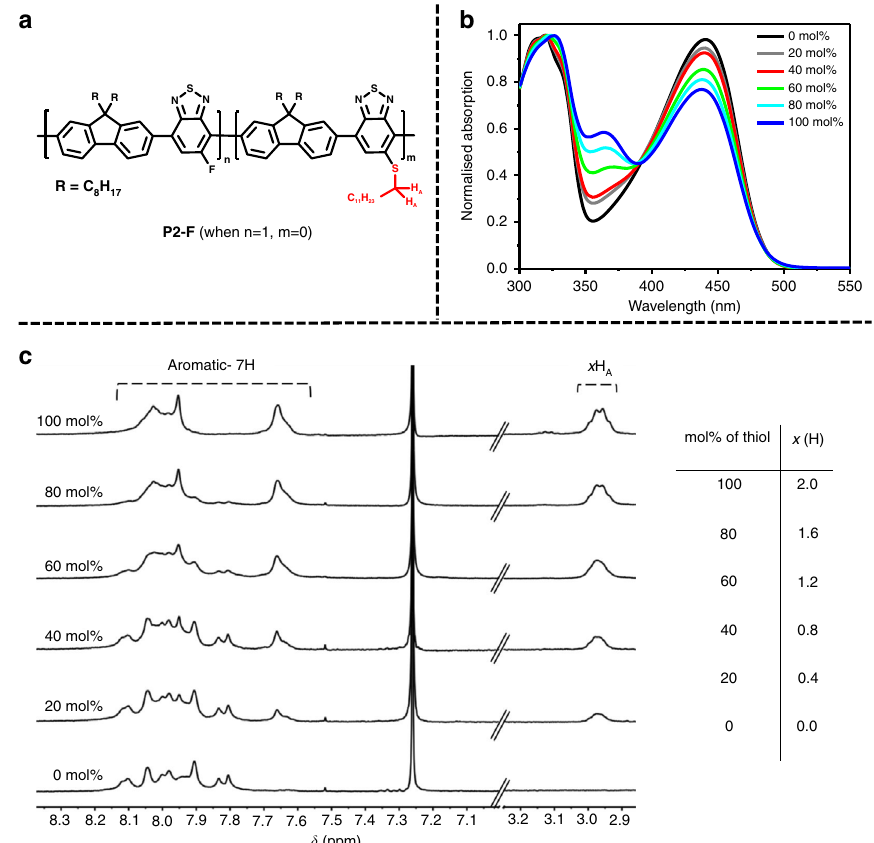
Fig. 2 Control of dodecanethiol substitution onto the backbone. a Structure of substituted polymer P2-F . b Normalised UV – Vis absorption spectra of each polymer, in chlorobenzene solution. c Stacked 1 H NMR spectra with increasing mol% of thiol, aromatic peaks integrated to 7H for each spectra. Integration value for H A ( x ) listed in table for each mol% of thiol